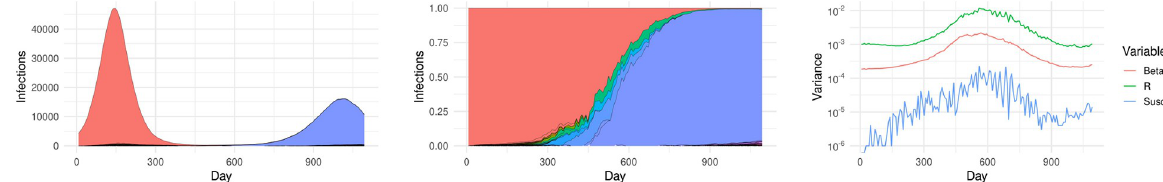
Fig 4. Example sample simulation, showing fixation of a novel variant. Antigenic types are separated by both line and color, though many colors appear similar. ( a ) Infections by antigenic type. ( b ) Antigenic type proportions. ( c ) Variance of fitness parameters.